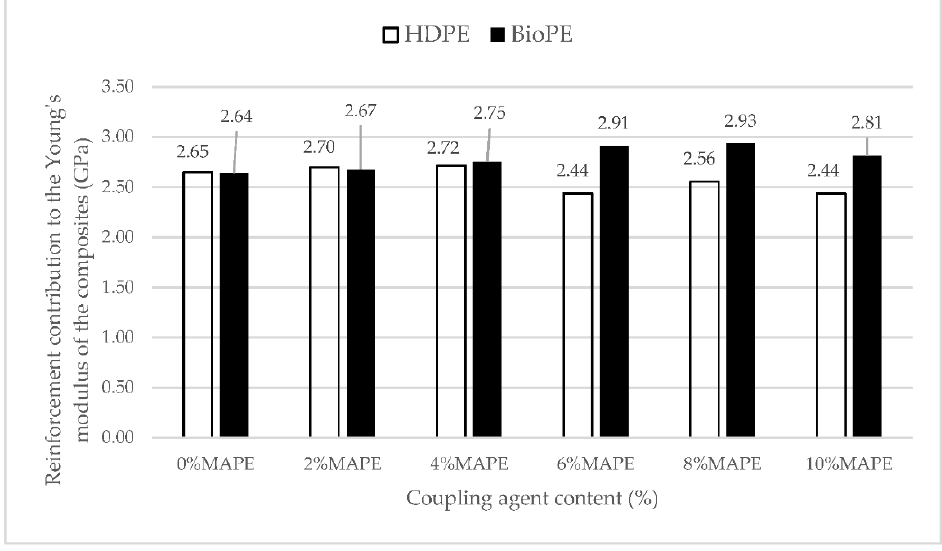
Figure 3. Abaca fiber contribution to Young’s moduli of HDPE and BioPE-based composites against MAPE content.